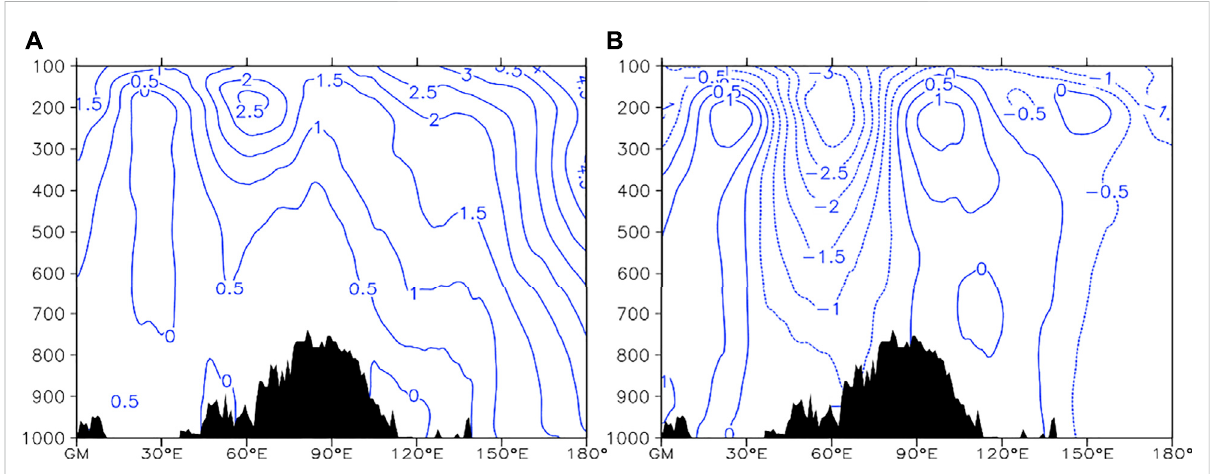
FIGURE 9 Longitude-altitude cross-sections of the average zonal westerly (unit: m s − 1 ; vector) anomaly of 20 – 45 ° N in (A) the stronger, (B) the weaker of FAT years. Shadow is the 4 km